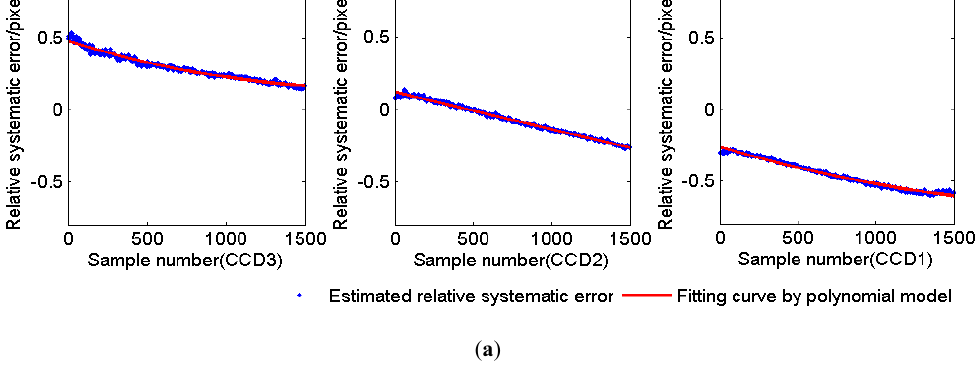
Figure 5. Parallax images between B1 and B2 along the track ( a ) Scene A, ( b ) Scene B, and ( c ) Scene C.